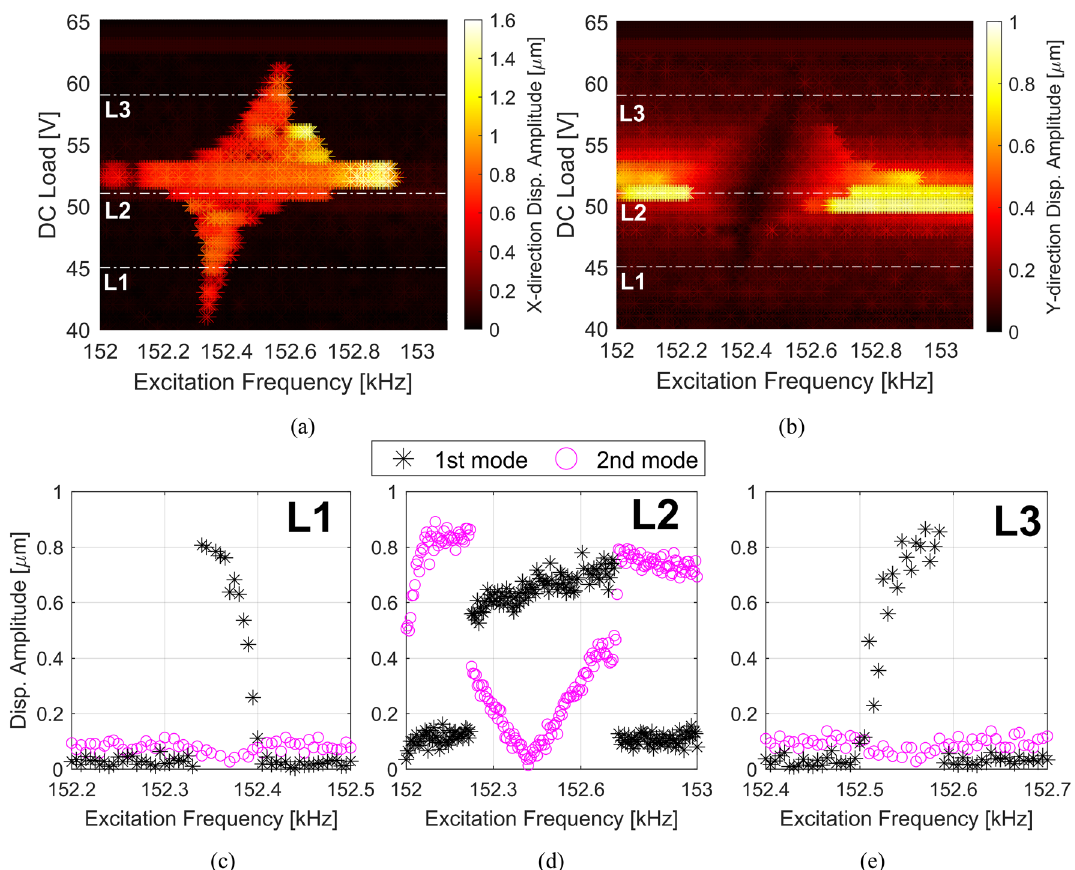
Figure 8. Experimental data of frequency responses surface (top view) for different DC loads through E2 excited around the 2nd mode frequency. ( a ) 1st mode. ( b ) 2nd mode. Both surfaces show the regions where the saturation phenomenon occurs, at which the 1st mode is activated. ( c – e ) Show the frequency responses of the 1st and 2nd modes for V DC2 = 45 V, V DC2 = 51 V, and V DC2 = 59 V, respectively. The curves show the different responses of the 1st mode under the saturation phenomenon when the ratios between 1st and 2nd modes are